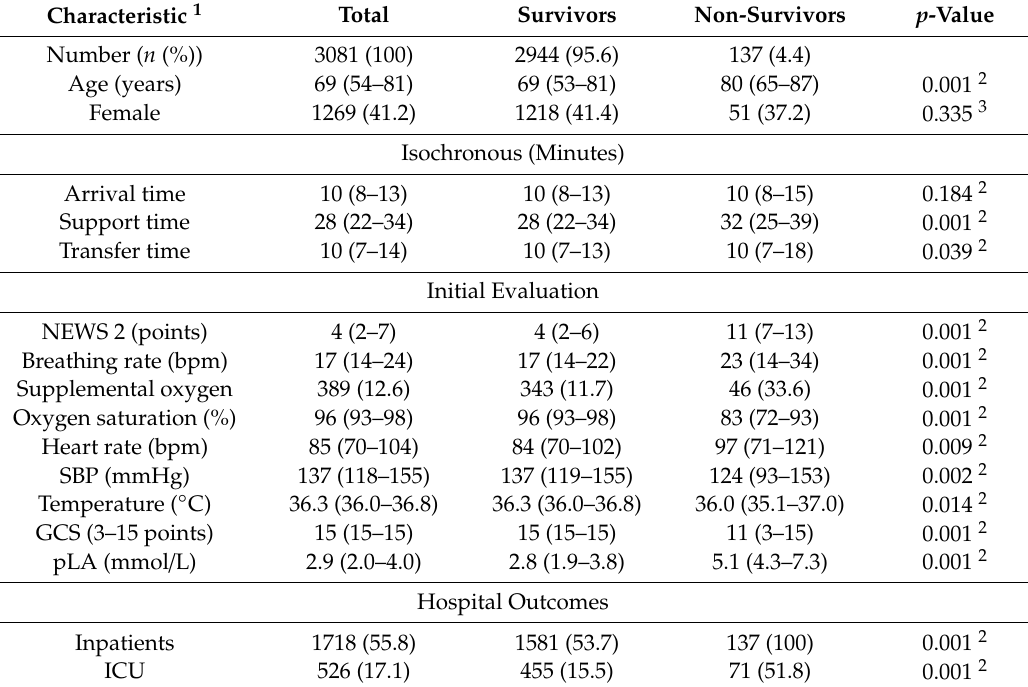
Table 2. Demographic, prehospital, and hospital characteristics of study subjects (death statistics refer to mortality rates in less than 48 h).